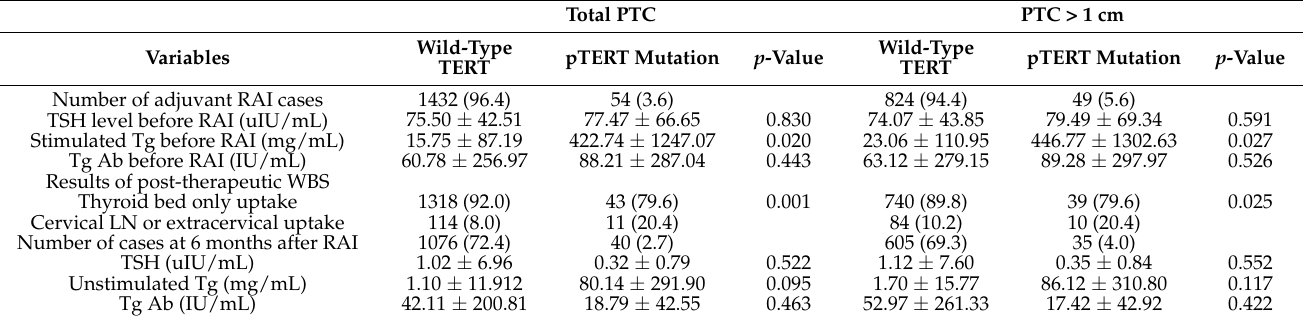
Table 5. TERT promoter mutation in patients with PTC and adjuvant radioactive iodine therapy. Total PTC PTC > 1 cm Variables Wild-Type TERT pTERT Mutation p